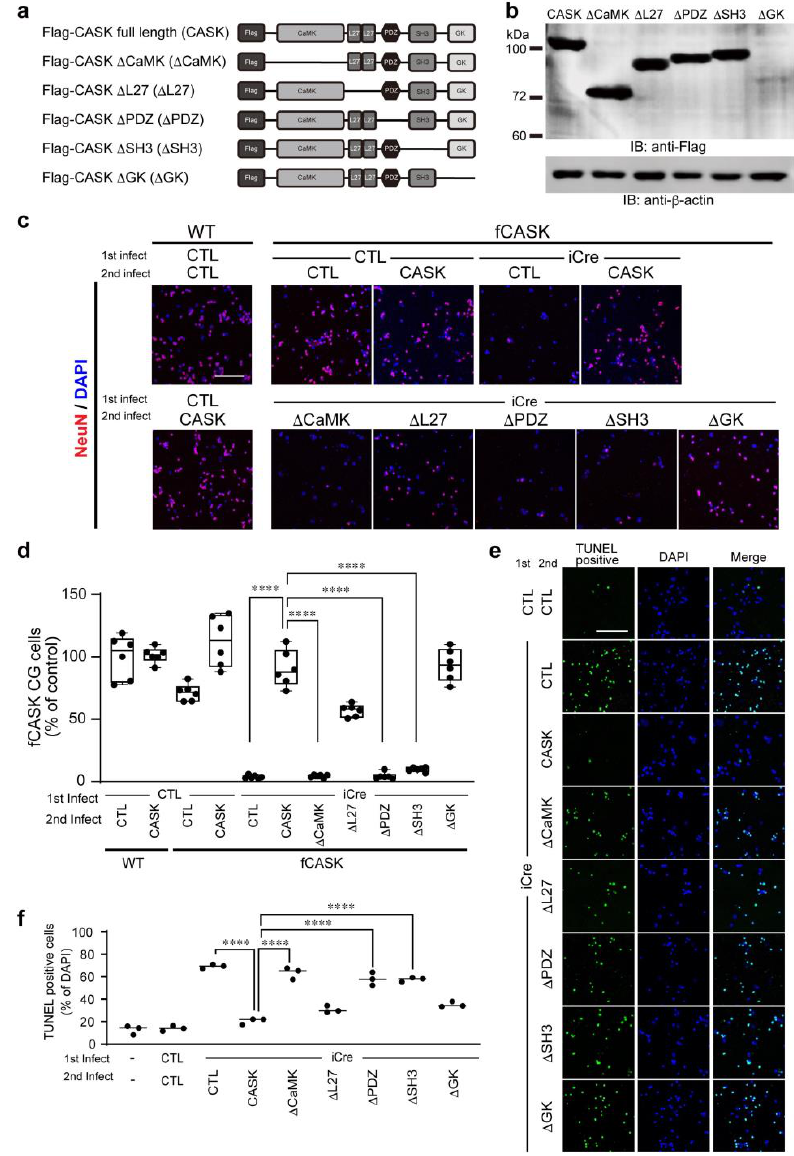
Figure 4. CASK deletion mutants affect the survival of cultured CG cells. ( a ) Schematic diagrams of full-length CASK and deletion mutants. ( b ) Western blot image for studying the expression of CASK deletion mutants. Cell lysates of WT CG cells infected with lentiviruses expressing the flag-tagged full-length and deletion mutant CASK are separated by SDS-PAGE, followed by Western blotting with anti-Flag and β-actin antibodies, respectively. ( c ) Effects of expression of CASK mutants on CASK KO CG cell survival. Cultured CG cells are infected with lentivirus-iCre (iCre) together with lentivirus-CASK (full-length or deletion mutants). Cells are stained with anti-NeuN antibody (red) and DAPI (blue). Scale bars = 100 μm. ( d ) Quantification of the number of NeuN-positive CG cells in ( c ). Each dot in the graph represents the average density of randomly selected three areas in each well. n = 6 (wells) in each group. Five to eight mouse brains were collected for preparing CG cell cultures to aliquot into each well. The horizontal line in each box indicates the median, the box shows the interquartile range (IQR), and the whiskers are the 1.5× IQR. **** p < 0.0001; one-way ANOVA. ( e ) TUNEL analysis of CG cells. Cultured CG cells are infected with lentivirus-iCre (iCre)